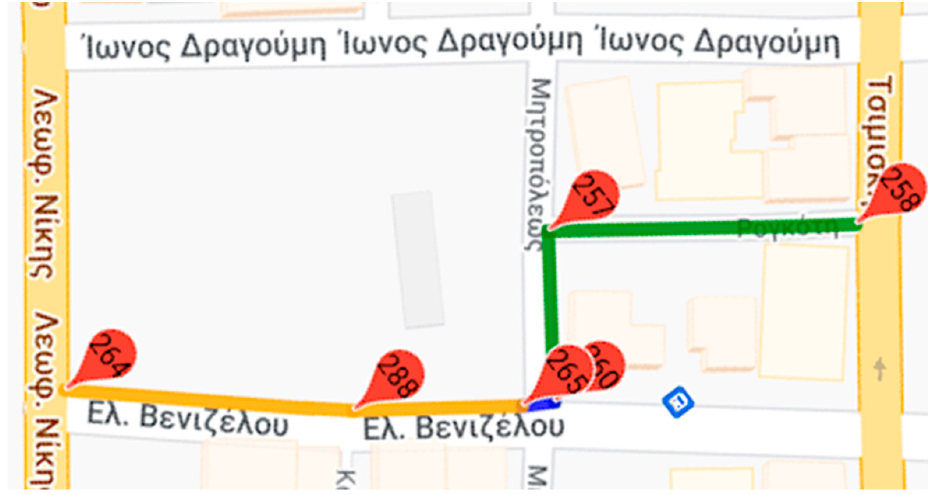
Figure 4. Shortest path between nodes 258 and 264.